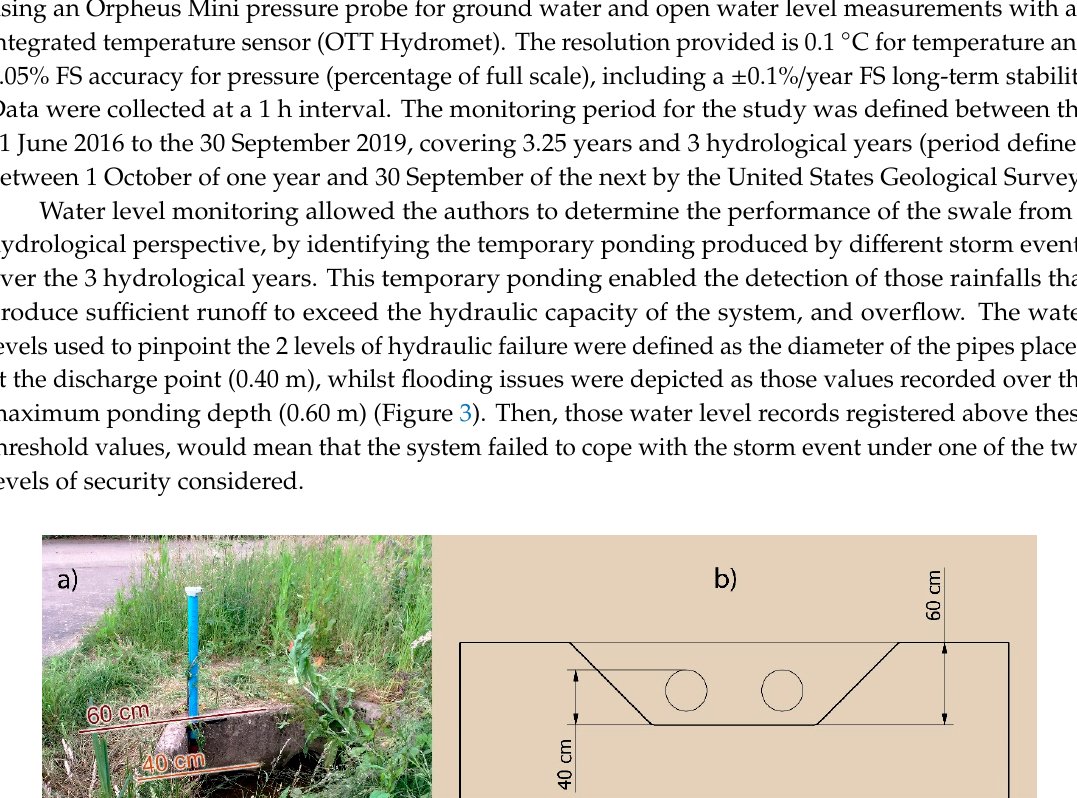
Table 4. Weather stations utilised in the study for the monitoring period of this research: 21 June 2019–30 September 2019. Source: UK Met Office. Station Name Latitude (N)